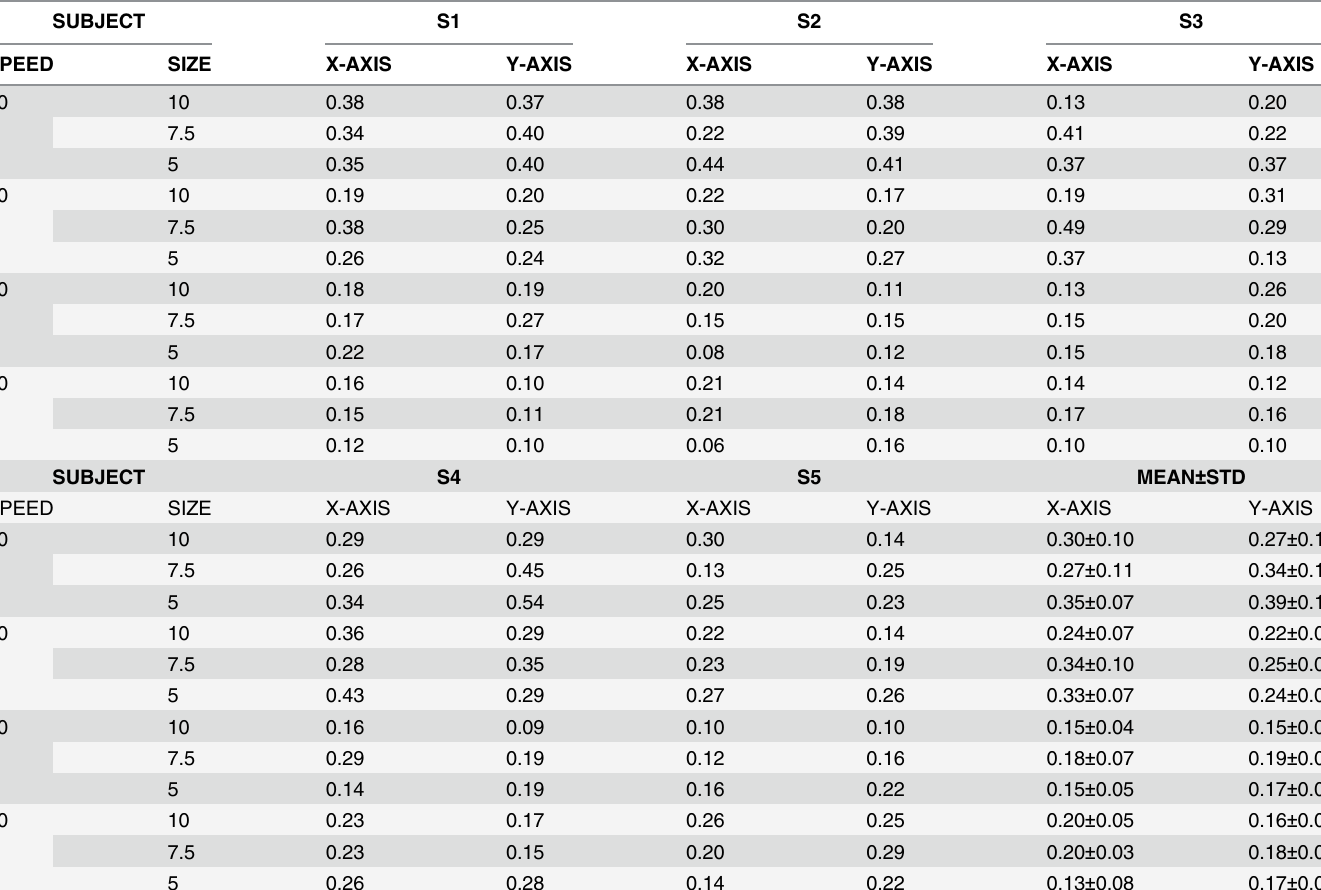
Table 2. Pearson correlation coefficients after decoding hand trajectories performed with the planar manipulandum for different disc speeds (mm/ s) and sizes (diameter in